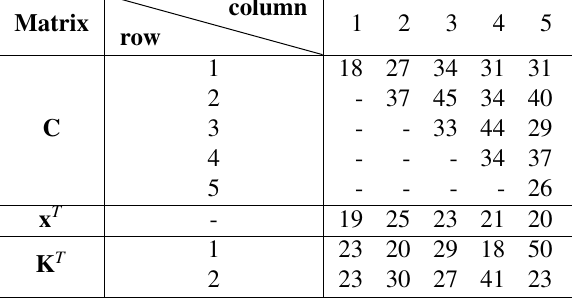
Table 1. The range of the exponent of floating point variables in the Kalman Filter state update.